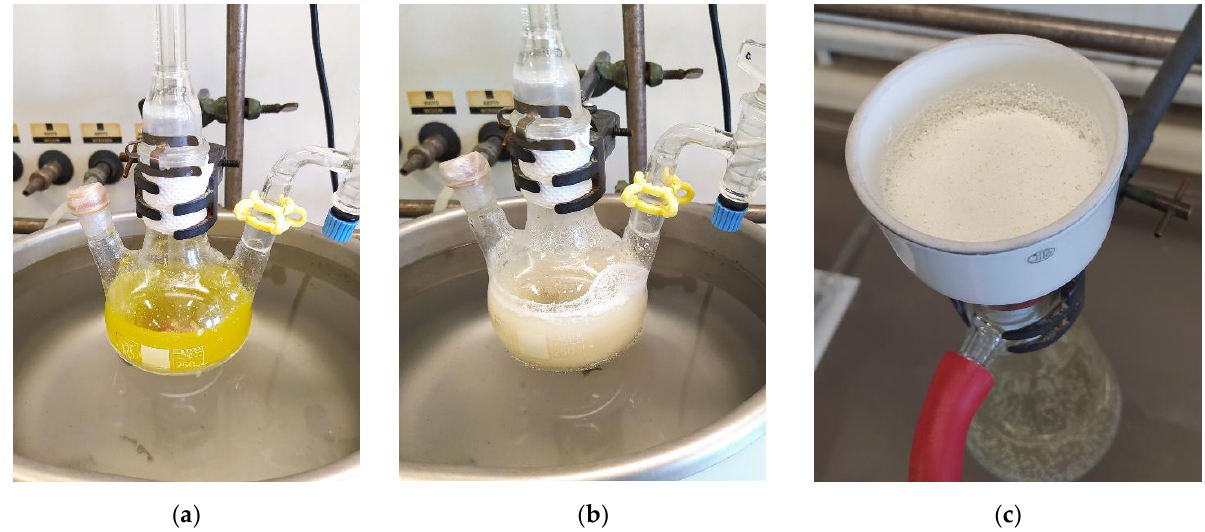
Figure 4. Laboratory scale, multigram synthesis of ( R )-10-hydroxystearic acid through hydration of oleic acid (50 g/L) by means of recombinant oleate hydratase and FADH 2 as a cofactor: ( a ) reaction mixture before titanium (III) citrate addition; ( b ) reaction mixture six hours after titanium (III) citrate addition; ( c ) ( R )-10-hydroxystearic acid obtained by filtration of the reaction mixture, after 48 h of reaction time.